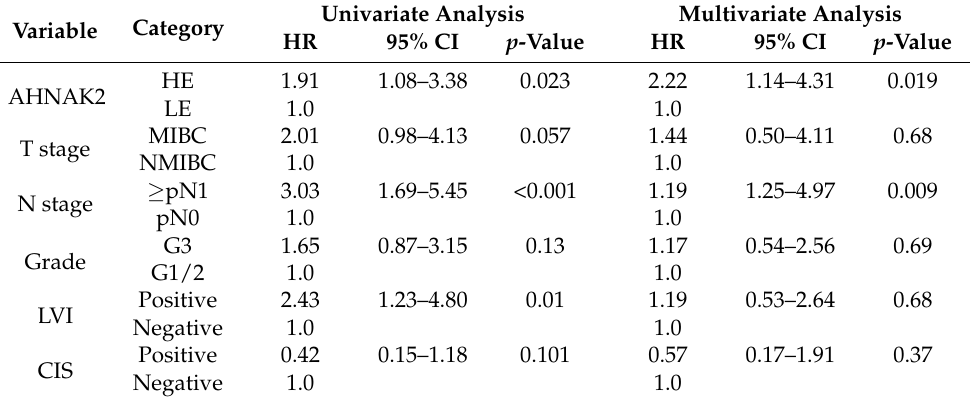
Table 3. Univariate and multivariate analyses for worse cancer-specific survival. AHNAK2, T stage, N stage, grade, LVI, and CIS were evaluated, and statistically significant values are highlighted in bold.